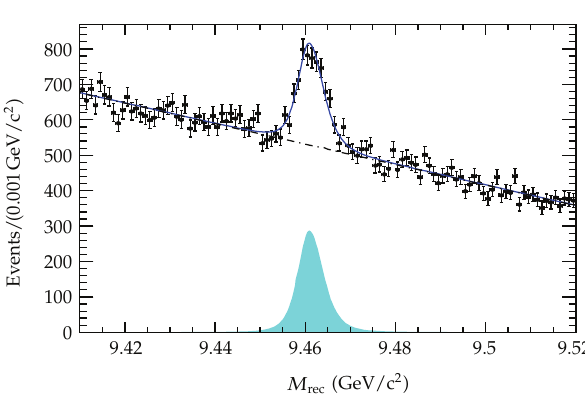
Figure 3: The distribution of the dipion recoil mass (cid:2) M rec (cid:3) for BABAR data, together with the result of the maximum likelihood fit (cid:2) full line (cid:3) . The nonresonant background (cid:2) dashed line (cid:3) and the sum of the signal and the peaking background (cid:2) solid filled (cid:3) are also